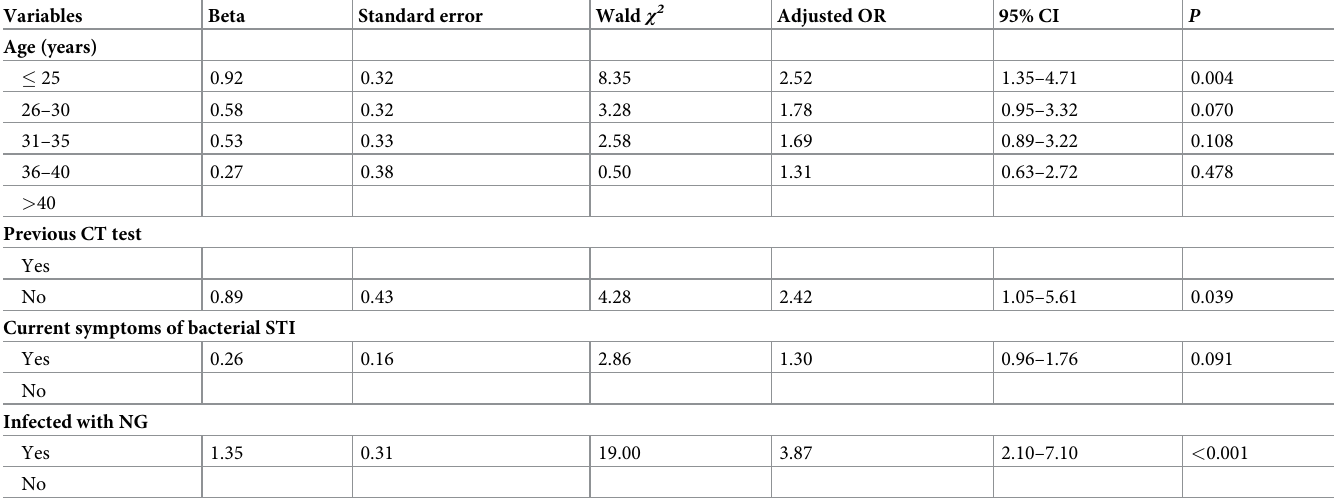
Table 3. Factors associated with CT: Multivariate logistic regression